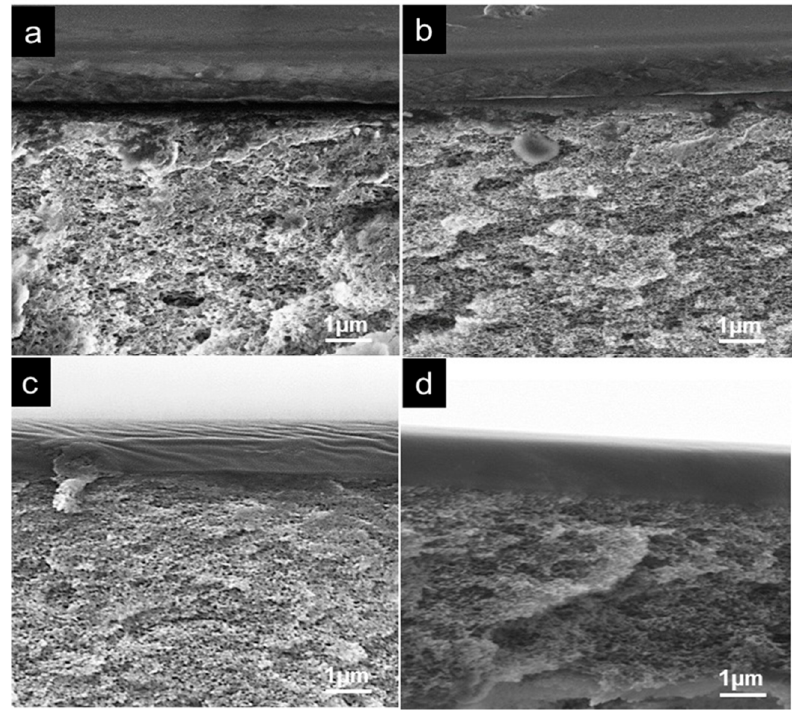
Figure 7. The cross-section SEM images of the composite membrane ( a ) PAN- r -PEGMA40; ( b ) PAN- r -PEGMA60; ( c ) PAN- r -PEGMA64 and ( d ) PAN- r -PEGMA67.